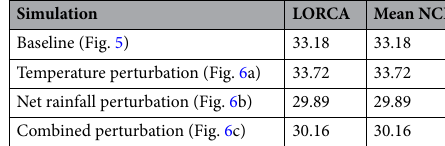
Table 2. Comparison of LORCA and NCB (g C m −2 year −1 ) for the DigiBog simulations shown in Figs. 5 and